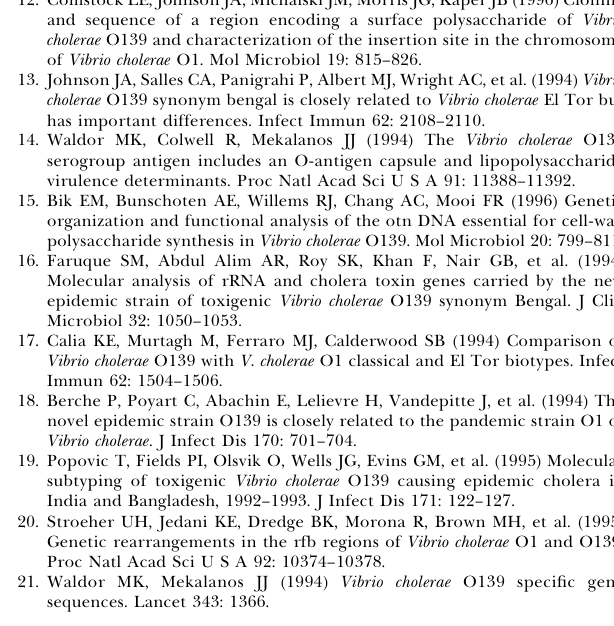
Figure S5. CGH of DNA Regions That Differ between Strains A1552 and MO10 Absent/present genes in the donor strains VCO139-Kan and MO10 (lanes 1 and 5, respectively; labeled with Cy5) or the transformants